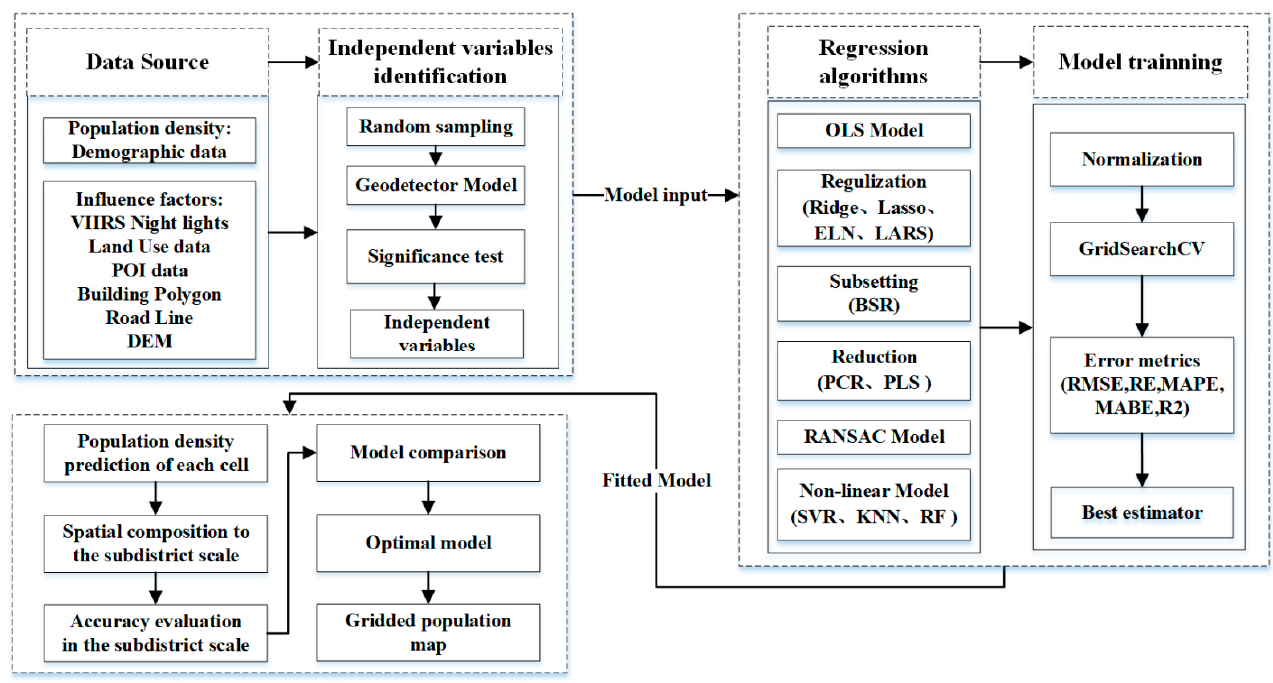
Figure 2. Technology roadmap.